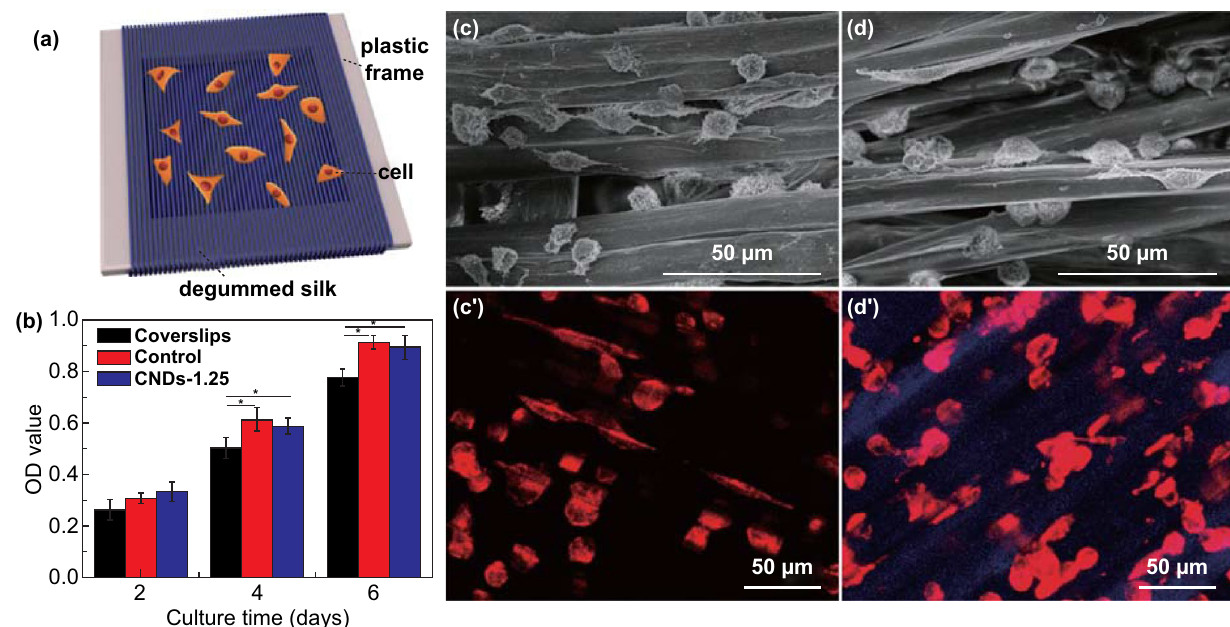
Fig. 4 Growth and proliferation of Schwann cells (SCs) on multi‑functional silks. a SCs cultured on silk scaffolds, constructed by wrapping silk around a hollow plastic frame. b OD value of SCs cultured on different substrates (coverslips, control, and CNDs‑1.25 silk scaffolds) after 2, 4, 6 days. c – d ′ SEM images ( c , d ) and LSCM images ( c ′ , d ′ ) of SCs after culturing for 4 days on control ( c, c ′ ) and CNDs‑1.25 silk scaffolds ( d , d ′